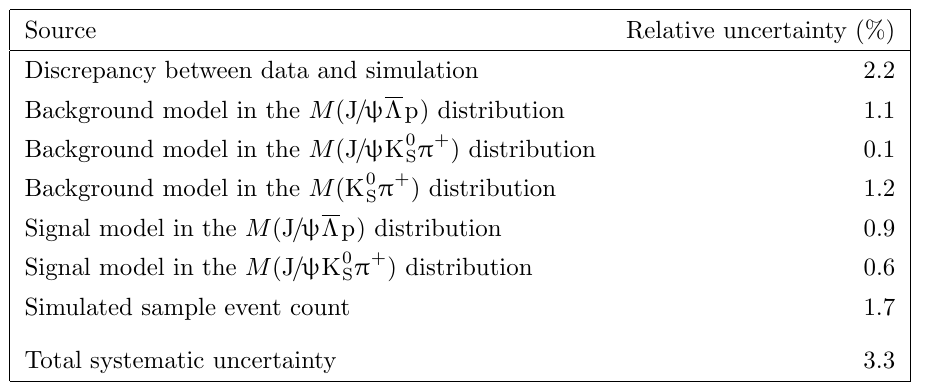
Table 2 . Summary of the relative systematic uncertainties in the B (B + ! J = (cid:3)p) = B (B + ! J = K (cid:3) + )